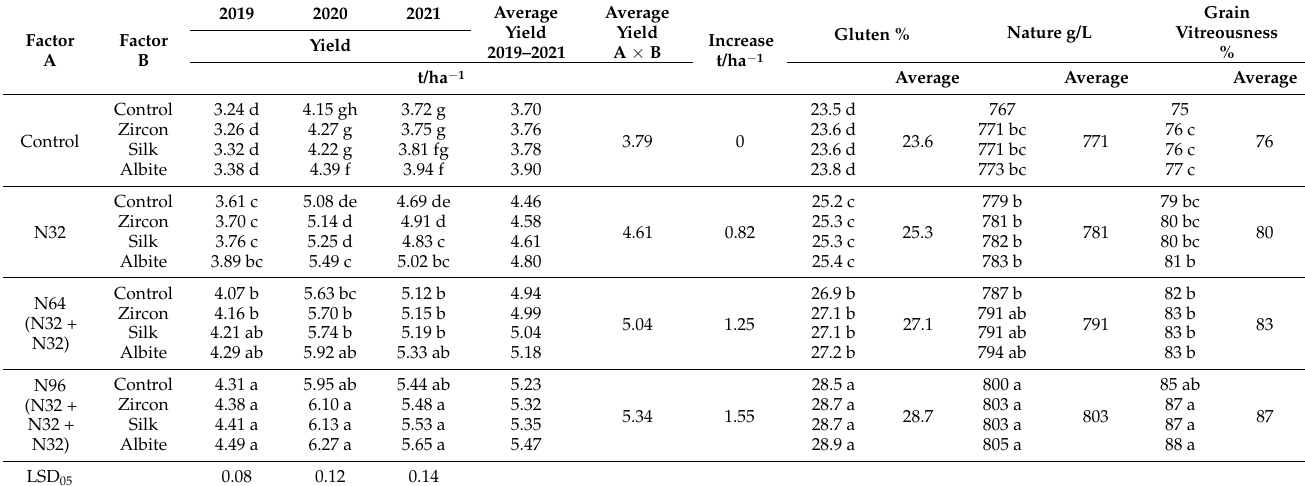
Table 1. Efficacy of experimental treatments on wheat grain yield and yield quality from 2019 to